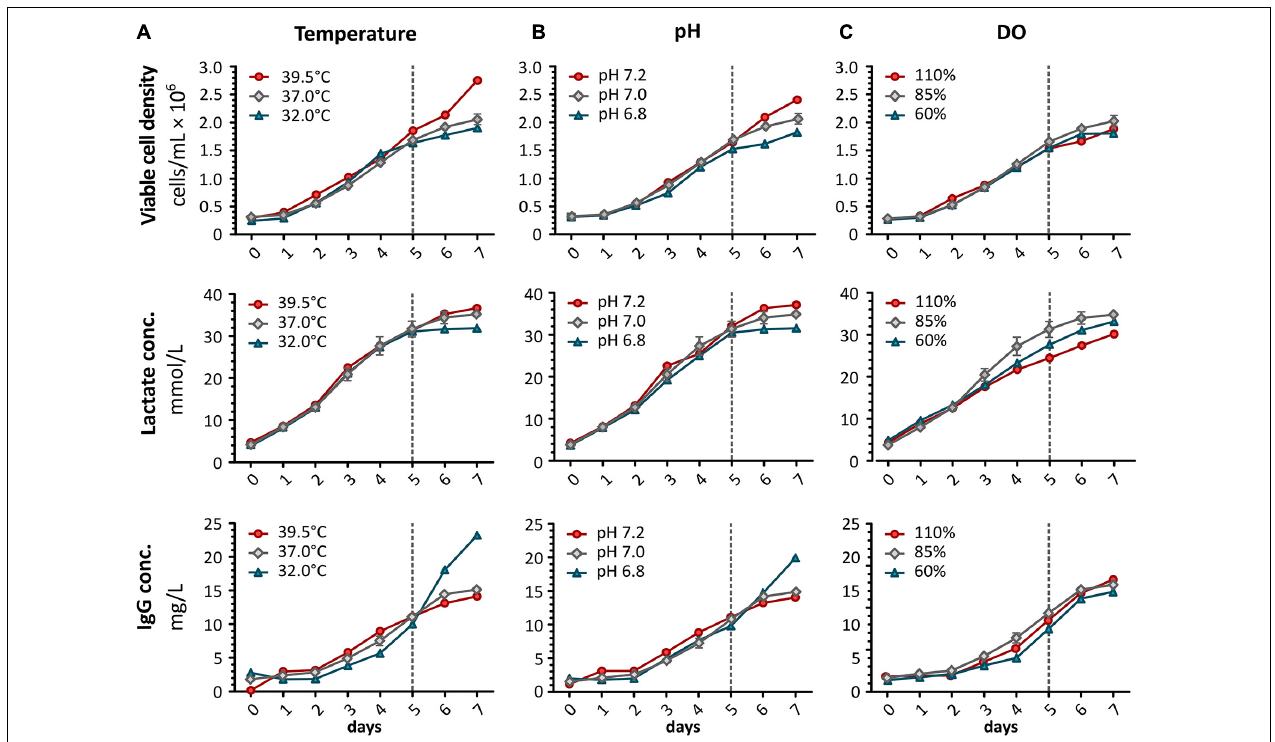
FIGURE 2 | For bioprocess monitoring of CHO DP-12 batch cultures, viable cell density was determined daily using the trypan blue exclusion method. Additionally, lactate concentration and IgG production were analyzed using a Cedex Bio Analyzer (Roche). Shown are results after shifting (A) temperature, (B) pH, or (C) DO concentration. Red shows an increase whereas blue indicates a reduction of the correlating parameter. Results obtained from standard conditions are shown in gray (mean ± standard deviation, n = 3). Dashed line indicates time point (day 5) for alterations of process parameters.